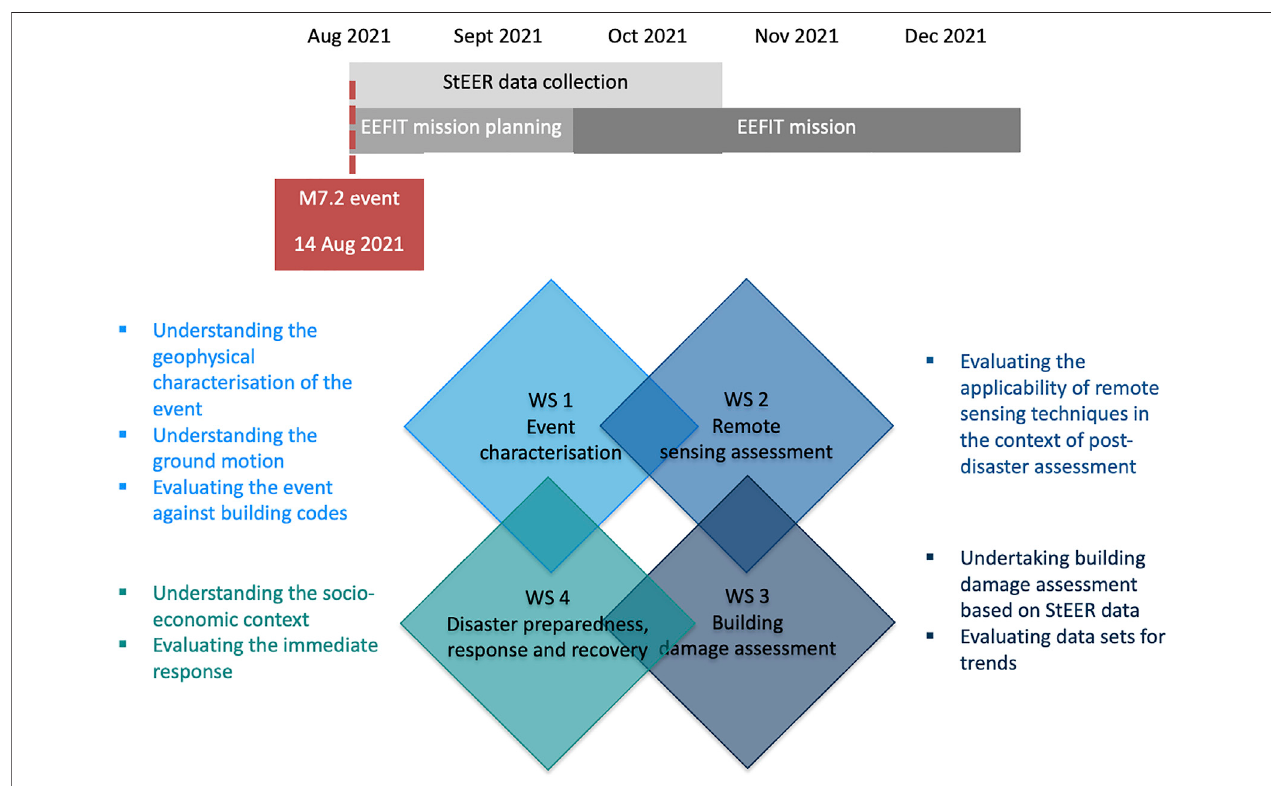
FIGURE 2 | Timeline and structure of the remote mission into four workstreams.